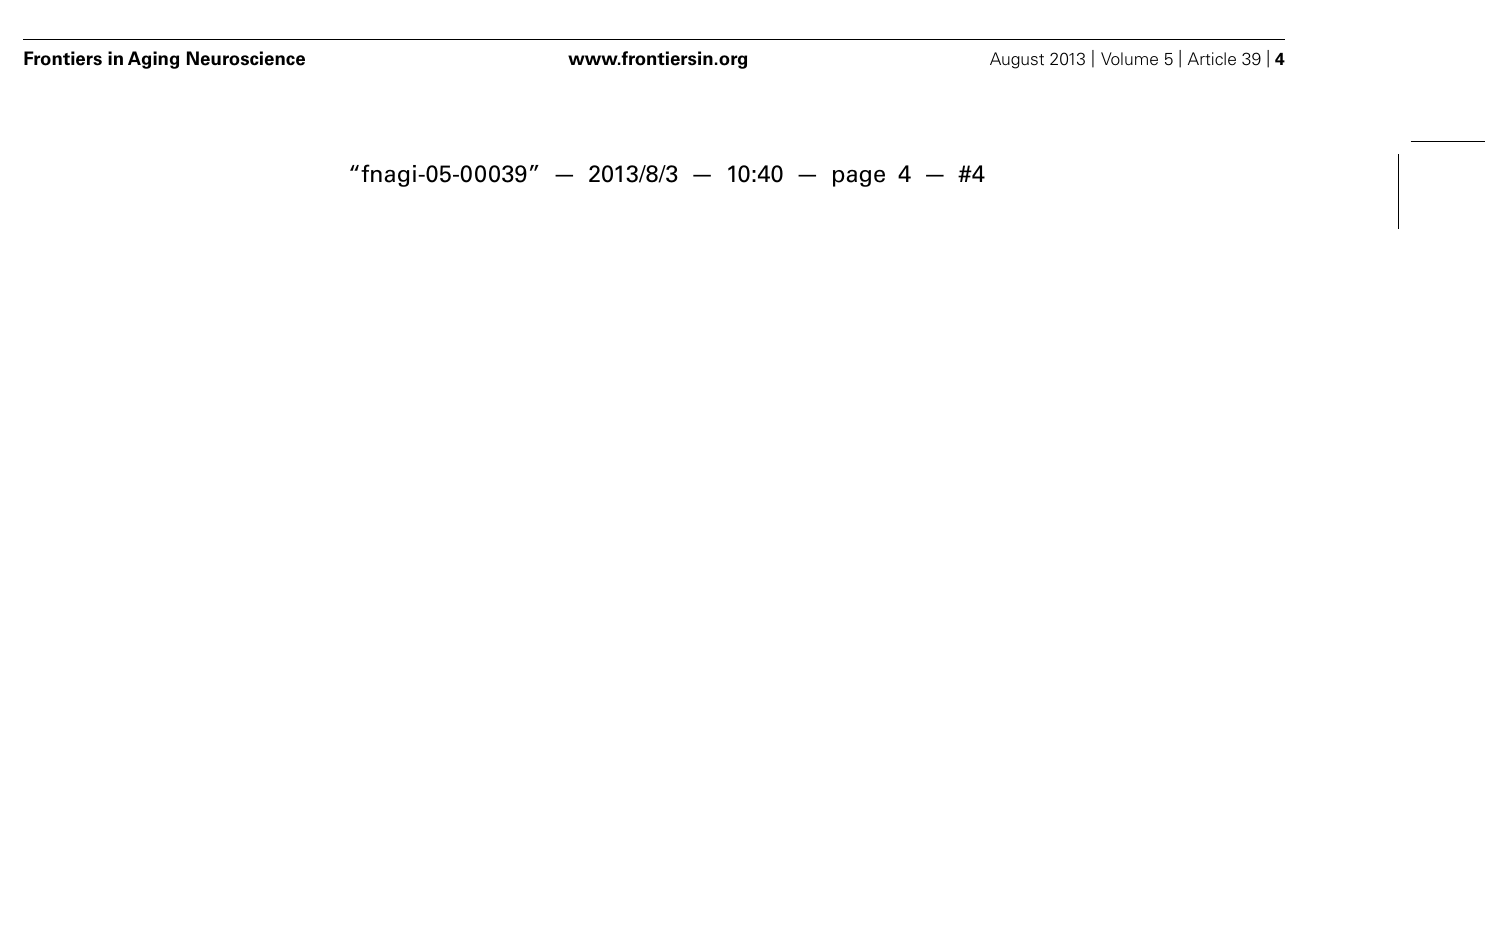
FIGURE 2 |AMPA receptor-mediated currents at single synapses are reduced in aged mice. (A) mEPSCs were collected in the presence of TTX.Top raw traces were extracted from 200 s recording epochs from which spontaneous currents were collected. Middle traces are expanded sections of the top traces; a template algorithm was used to search for individual currents. Bottom traces are selected individual mEPSCs aligned according to onset of the current. (B,C) All currents collected during the 200 s epochs were binned according to amplitude. As demonstrated by these representative histograms, AMPA mEPSC amplitude histograms in